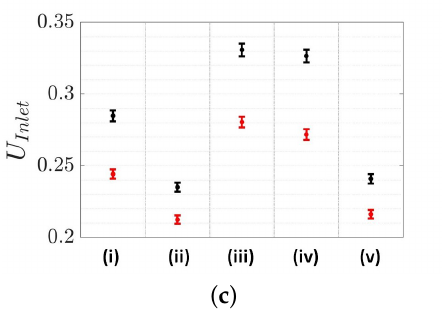
Figure 10. Measures of slipstream velocities for ( a ) parallel fins (passenger side) ( b ) parallel fins (danger side) and ( c ) circulation injection. Black symbols show the slipstream measure for the baseline case and red symbols show predictions with controls implemented. Percentage change for all devices is summarised in Table